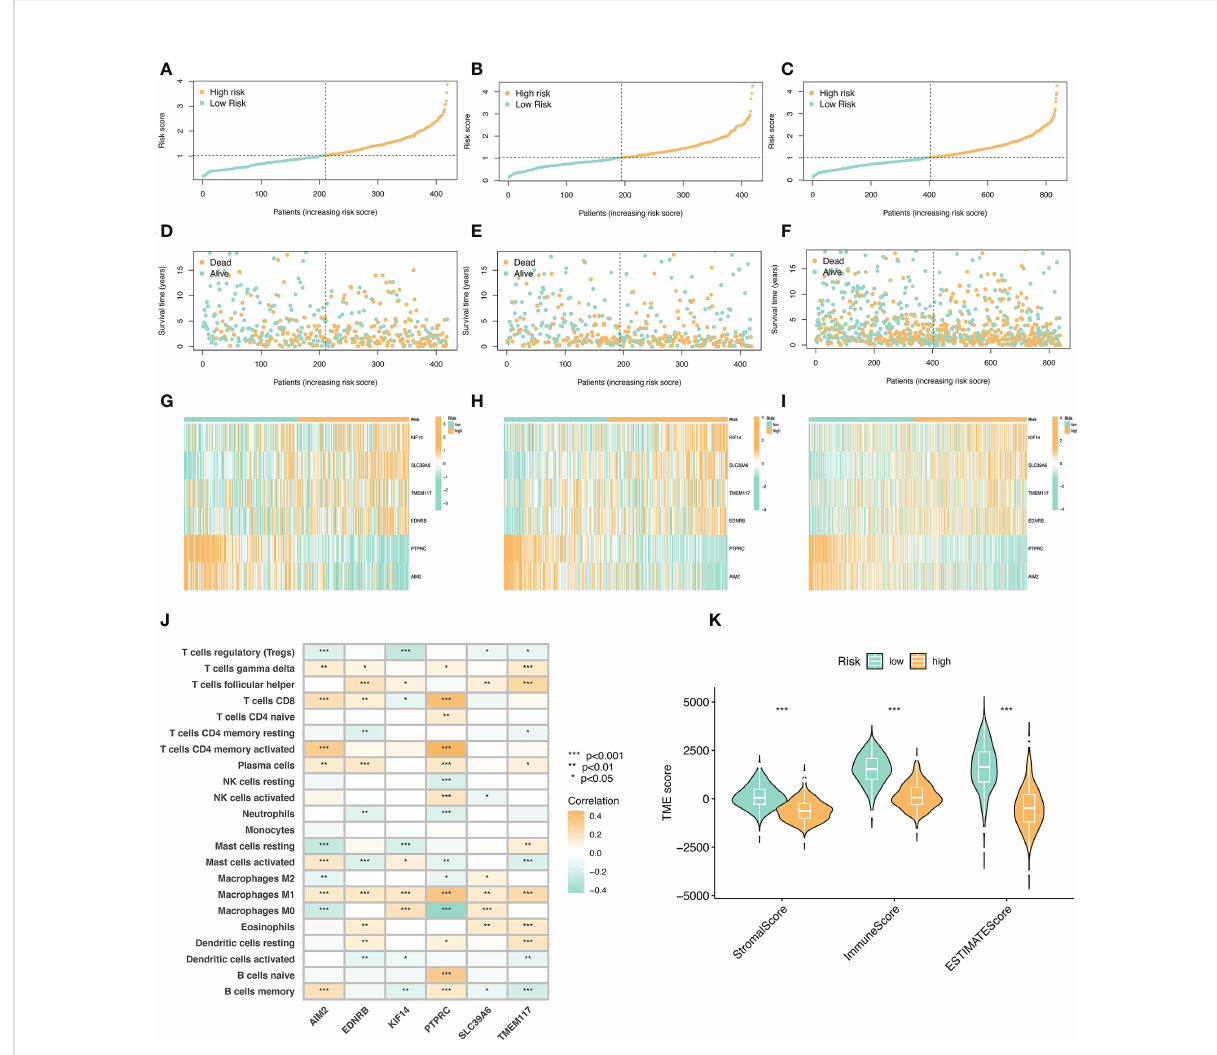
FIGURE 5 Risk curve and immune microenvironment analysis between high and low immune groups. (A) Risk curve in the training set. Take the median of the risk scores and use the median to divide the samples into high-risk and low-risk groups. (B) Risk curve in the validation set. (C) Risk curves of all samples. (D) Survival state diagram of the training set, red for dead and blue for survival. (E) The living state diagram of the validation set. (F) Survival state diagram of all samples. (G – I) Heat map showing the expression of 6 key variable genes in training set, validation set and all samples. (J) Correlation of 6 key variable genes with immune cells, red represents positive correlation and blue represents negative correlation. (K) Correlation of stroma score, immune score, and ESTIMATE with immune